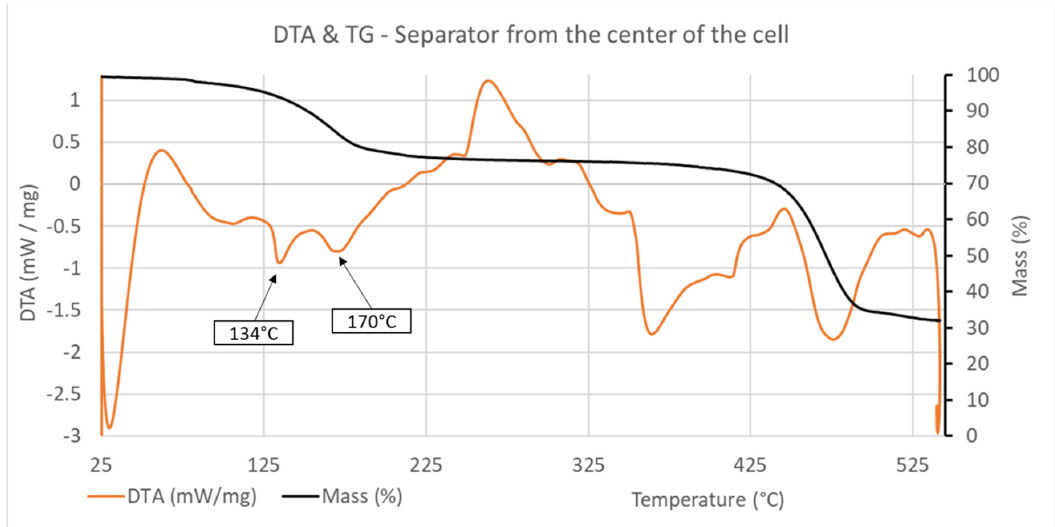
Figure 5. Thermogravimetric analysis (TGA) and differential scanning calorimetry (DSC) curves of separator as taken from opened cell, with no solvent rinsing and after several days of storage under ambient atmosphere.